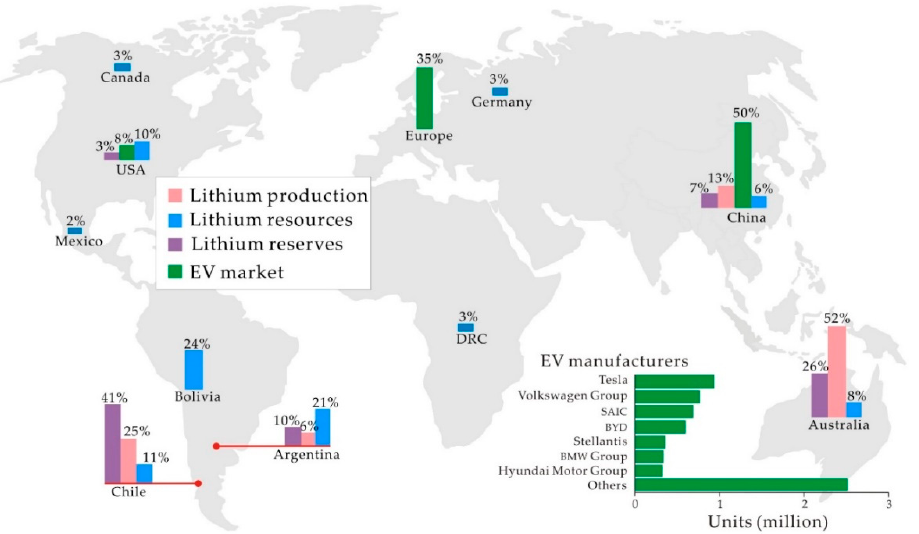
Figure 12. The availability of lithium and electric vehicle sales by countries in 2021. This figure presents round numbers of countries greater than 2% excluding the United States production. Data from [40,67].